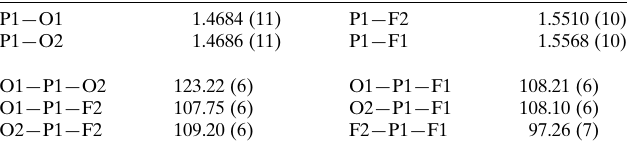
Table 2 Selected geometric parameters (A˚ , (cid:4)